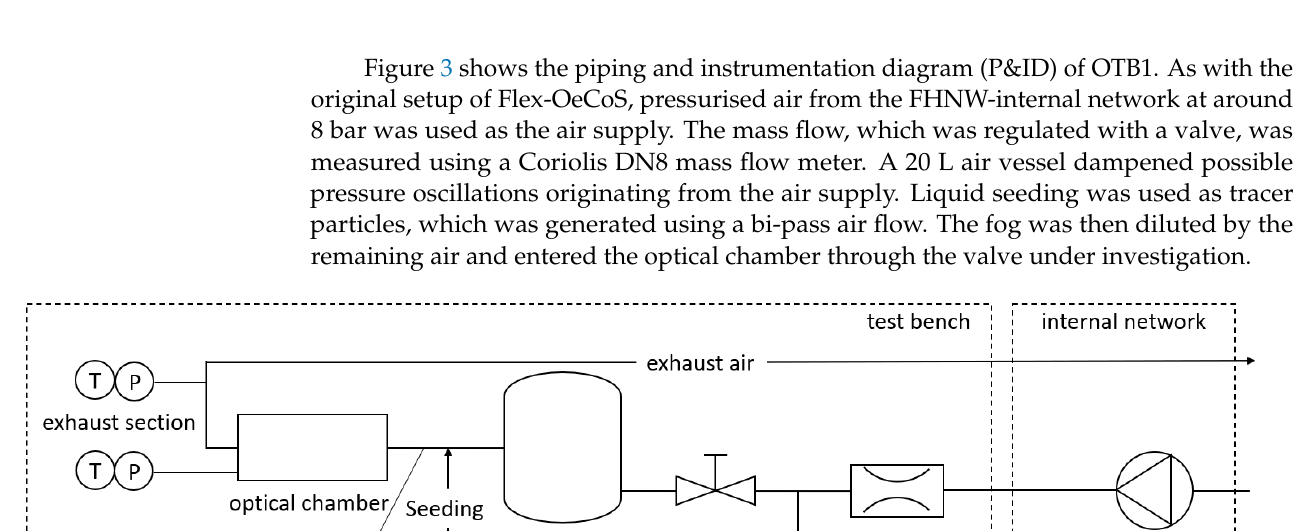
Figure 2. Cross-section through the optical chamber of OTB1 ( left ), the experimental setup ( middle ), and a photo of the experimental setup ( right ).